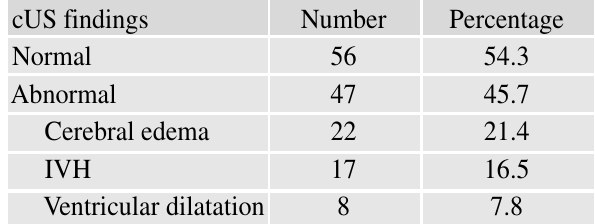
Table III: Cranial ultrasound (cUS) findings of the neonates (n=103) before discharge(cid:13) (cid:13) cUS findings(cid:9)